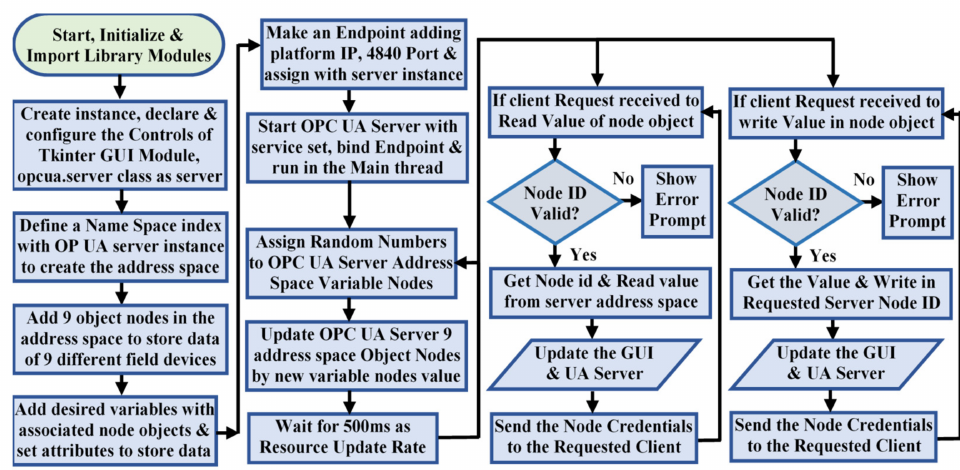
Figure 3. Process flow chart of the developed OPC UA